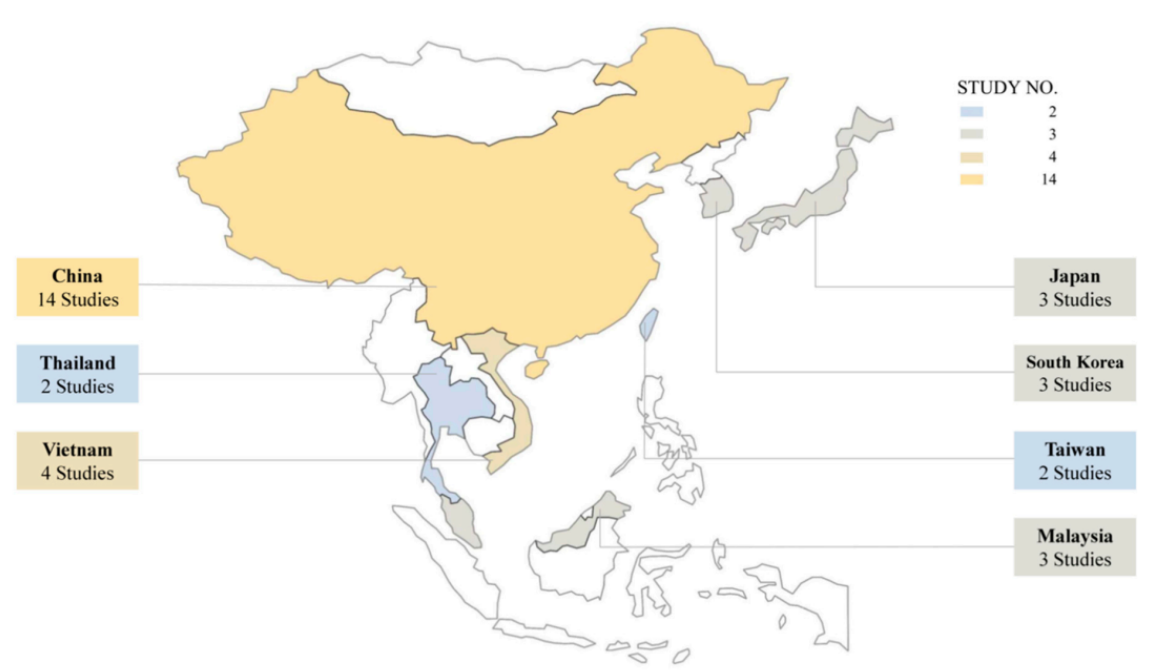
Figure 2. The number of studies in each territory included in the review. Note: Mongolia, Brunei, Cambodia, Indonesia, Laos, North Korea, and the Philippines were excluded from this review.